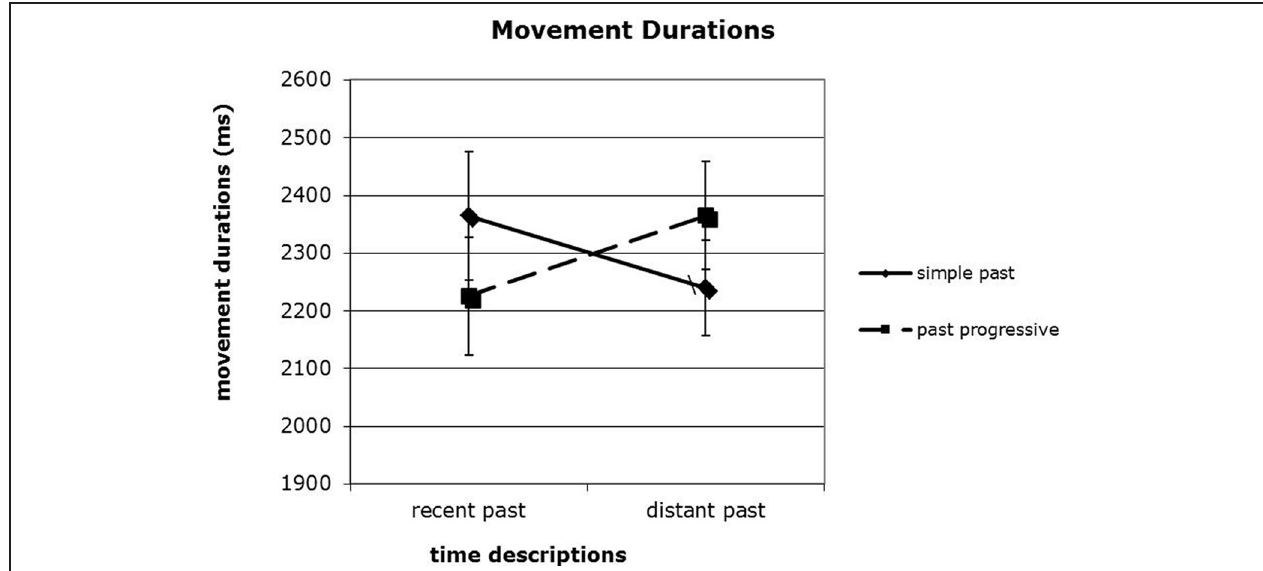
FIGURE 4 | Movement duration